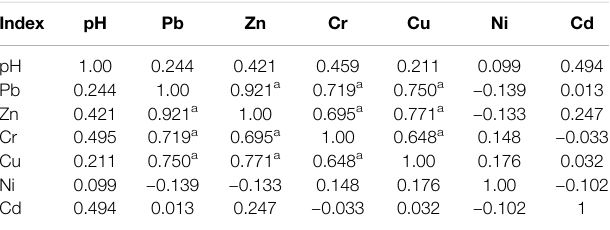
TABLE 4 | Correlation analysis of the pH and heavy metals in super fi cial sediments.